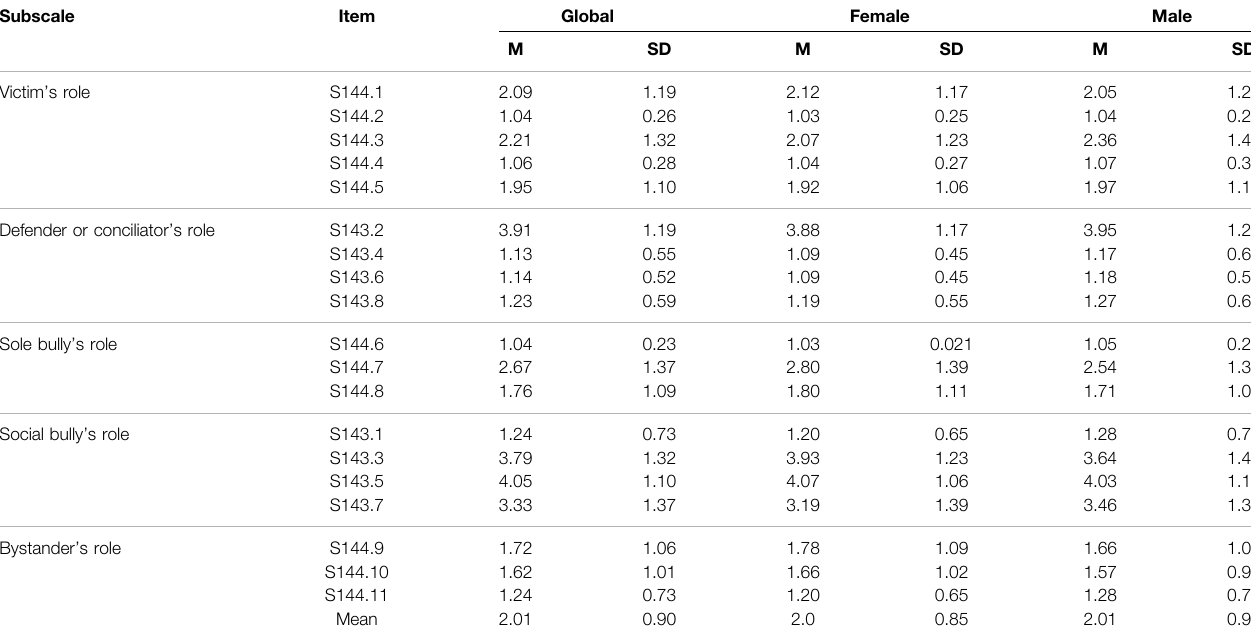
TABLE 2 | Global and by-gender descriptive statistics of the ERECVE items. Subscale Item Global Female M SD M SD M SD Victim ’ s role S144.1